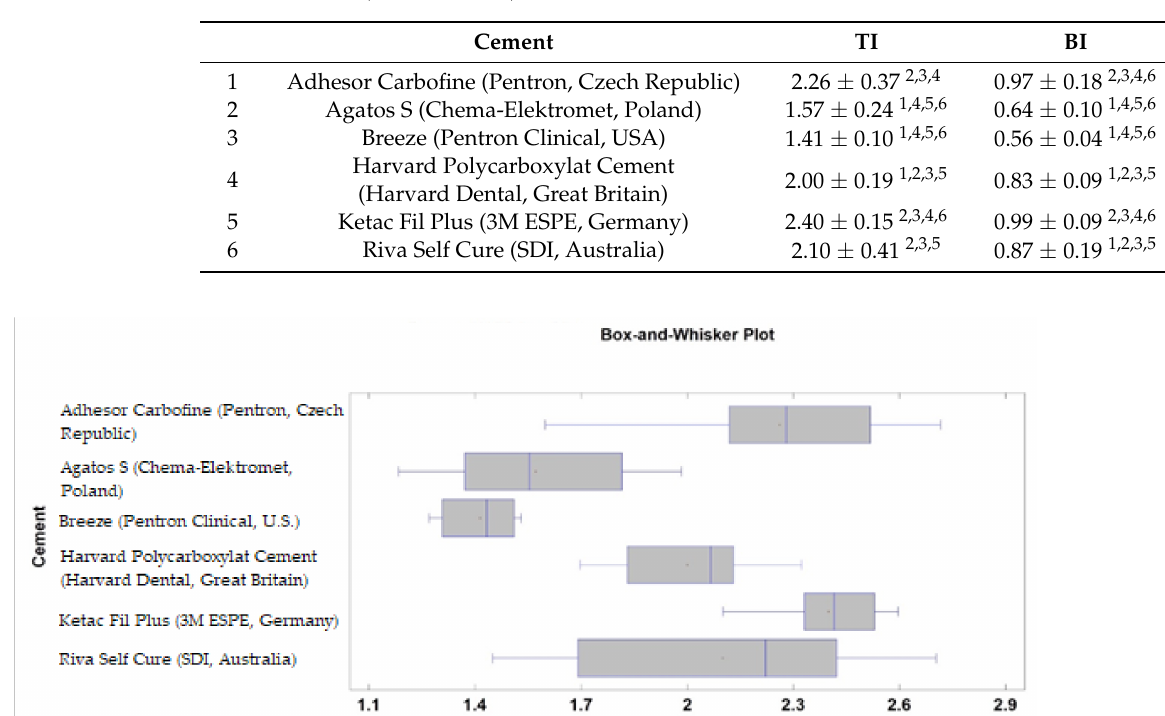
Table 4. Texture analysis. Mean value and standard deviation in the calculated texture indices.